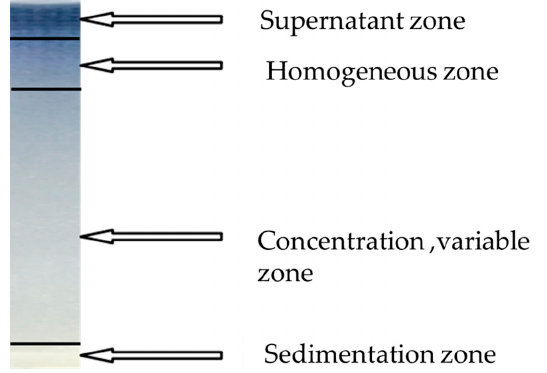
Figure 4. The regional divisions of nanoclay suspensions.